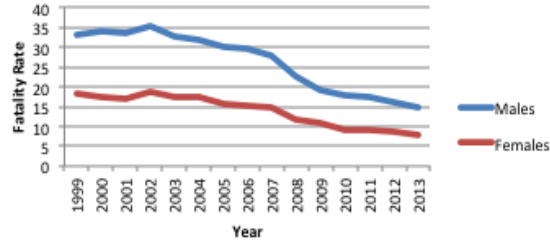
Figure 4. Rates per 100,000 of motor vehicle deaths in adolescents from 1999 to 2013 in US. Source: Centers for Disease Control and Prevention (2016).